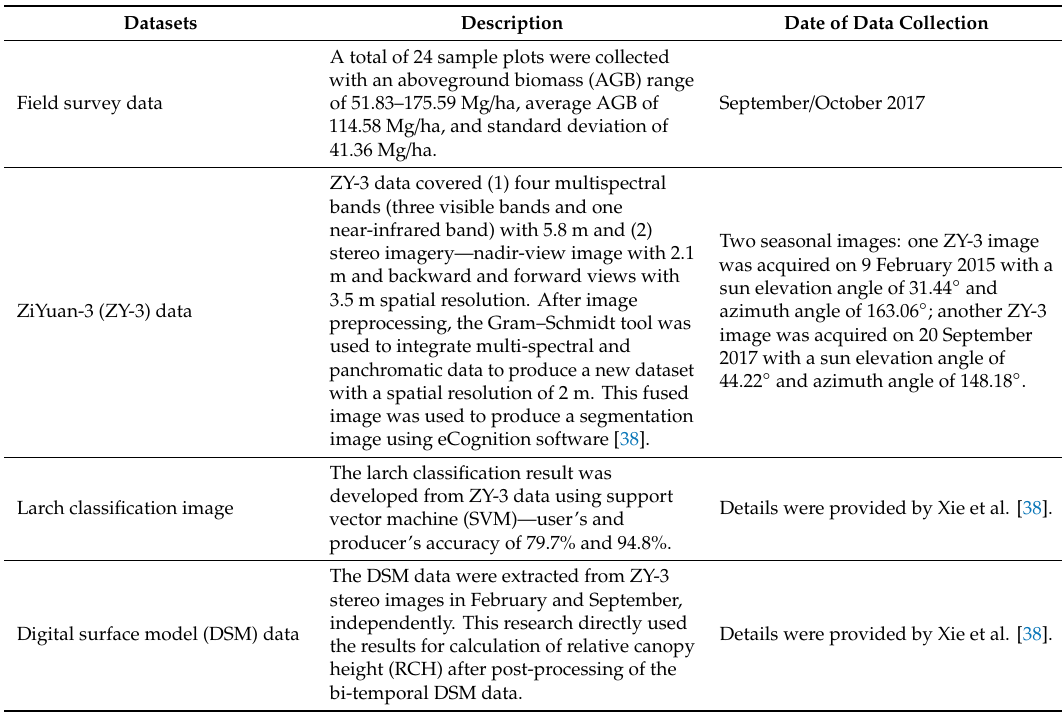
Figure 2. Framework of aboveground biomass estimation for larch plantations using ZiYuan-3 multispectral and stereo images. Table 1. A summary of data sets used in